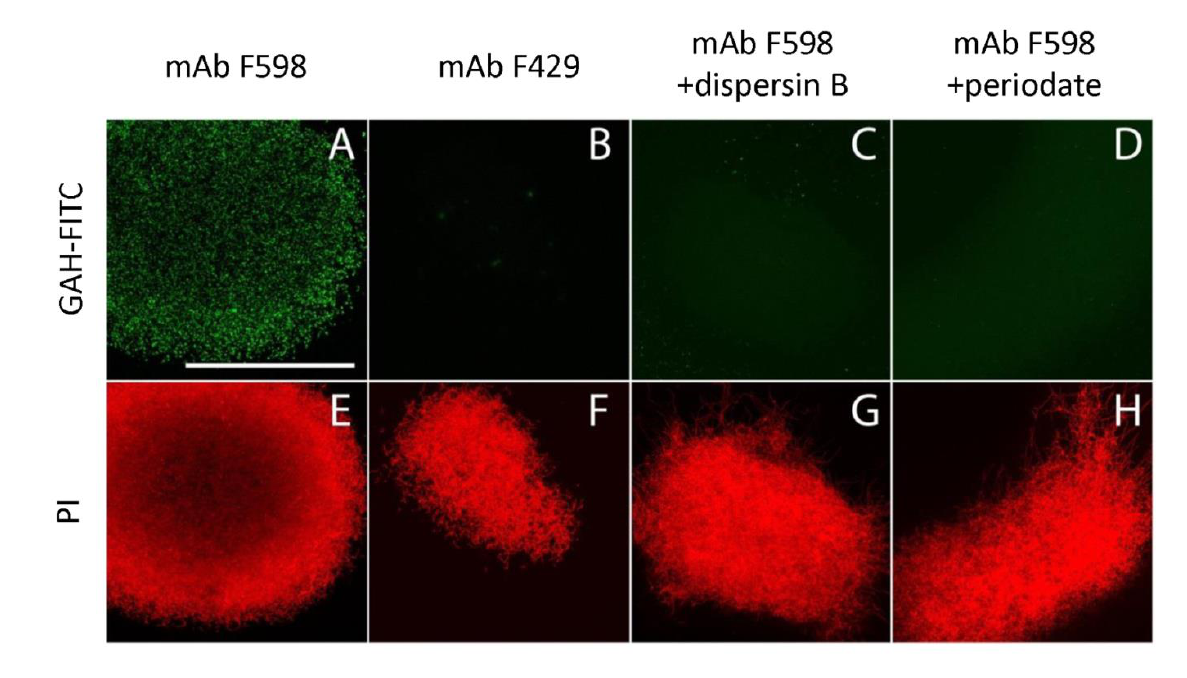
FIGURE 3: Immunofluorescence micrographs of S. lividans identifying extracellular PNAG . Mycelia from 18 h old cultures of S. lividans 66 were analyzed for the presence of PNAG with the monoclonal antibody mAb F598 and secondary anti-human IgG Alexa 488 conjugate (green) (A,C,D) . As controls for the specificity of the primary antibody we used mAb F429, a monoclonal antibody that binds alginate (B) , and samples treated with 50 µg/ml dispersin B (C) that degrades PNAG or with 0.4 M periodate (D) , which degrades β-(1,6)-glycans. To visu- alize the hyphae, the DNA was stained with propidium iodide (red) (E-H) . Bar, 100